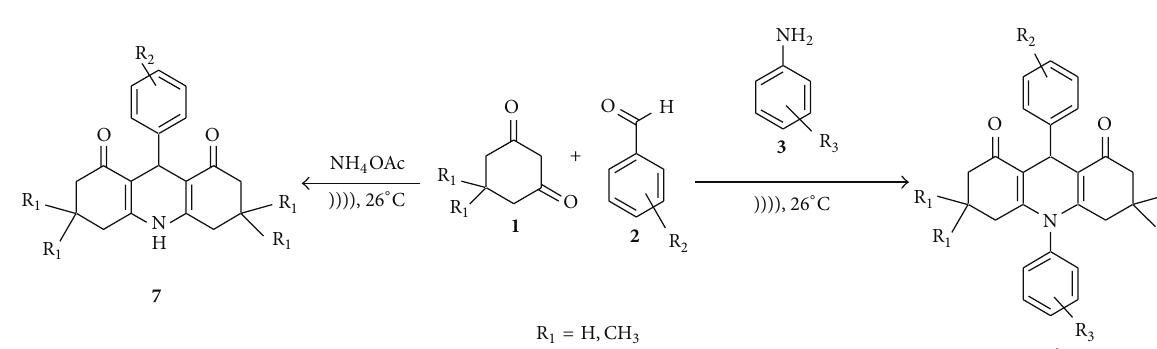
Scheme 1: Synthesis of acridines under sonic condition.